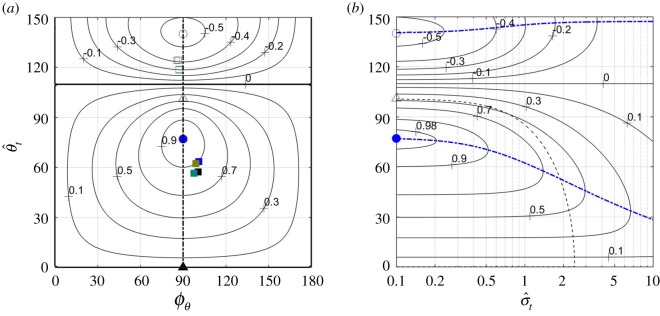
Contours of constant L¯(ϕθ,  θ^t,0.1) over the ϕθ– θ^t plane (a), and of constant L¯(π/2,  θ^t,σ^t) over the σ^t– θ^t plane (b). The values of L¯ along the dash-dotted vertical line on plate (a) are those found along the y-axis on plate (b). Thick solid lines on plate (a) highlight the contour L¯=0. Points and unmarked lines (either dashed or dash-dotted) on all plates show the combinations of parameters where the reduced thrust T¯ (triangles, dashed lines), the lift-to-thrust ratio L¯ (circles, dash-dotted lines) and the pitching moment-to-thrust ratio M¯z′,ref (squares) are either minimal (empty symbols) or maximal (filled symbols). The values of M¯z′,ref correspond to xref = 0.45 and ω − κ = 6, and the four combinations of shape functions shown in figure 4.